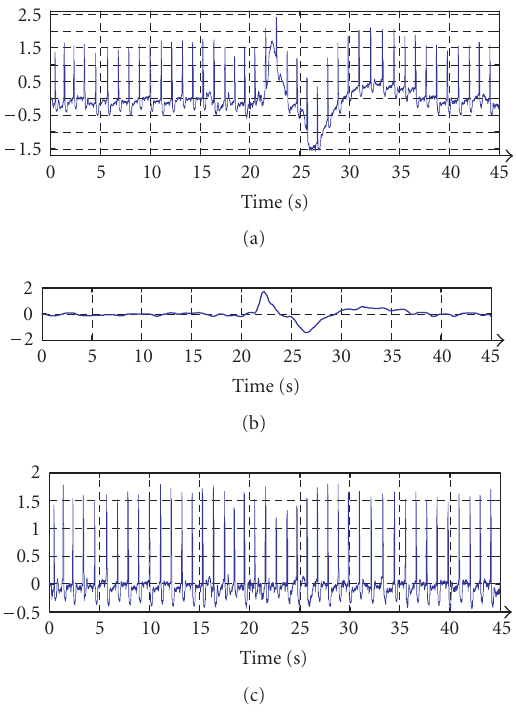
Figure 7: The ECG record “b210-1,” (a) original ECG signal, (b) estimated baseline drift, (c) ECG after removing the